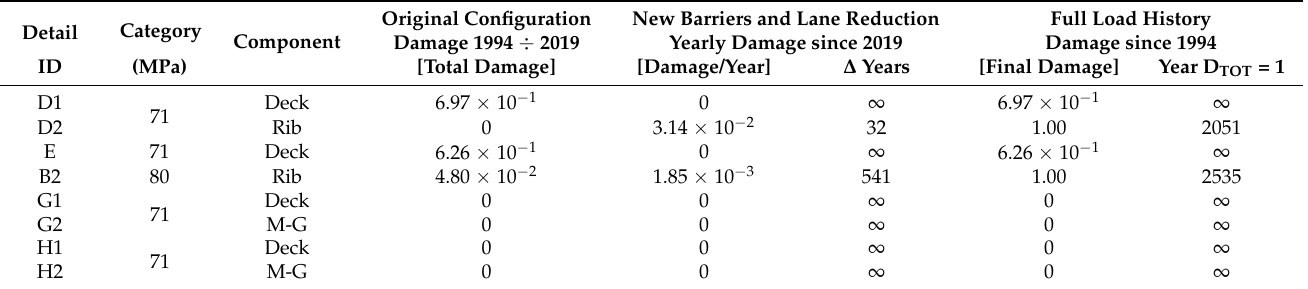
Table 13. Results of damage checks—Group 2(Left)—Accumulation of damage due to the actual full load